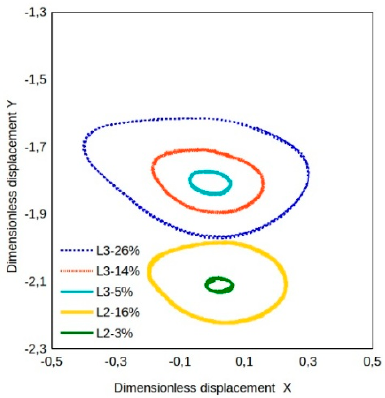
Figure 10. Orbits of the five-pad TPJB generated by the rotating force. Cyan, red, and blue lines for lower static load L3 and increasing dynamic/static load ratio, and green and yellow for higher static load L2 and increasing dynamic/static load ratio.